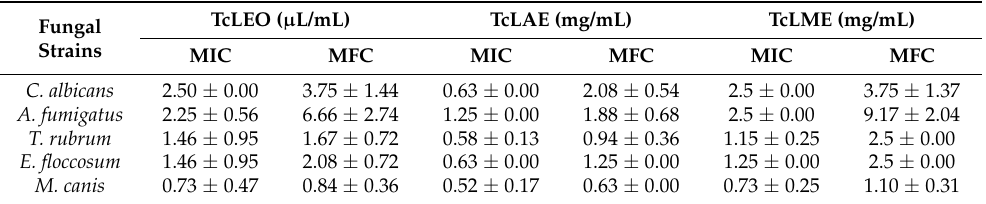
Table 5. Minimum inhibitory concentration (MIC) and minimum fungicidal concentration (MFC) of the Thymus capitatus extracts (TcLME, TcLAE), and essential oil (TcLEO). TcLEO ( µ Fungal Strains